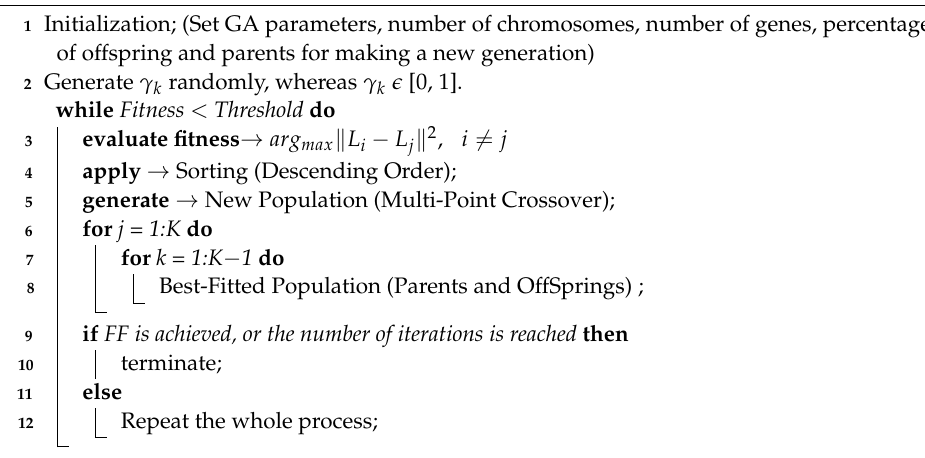
Algorithm 1: GA-Based Optimal Weight